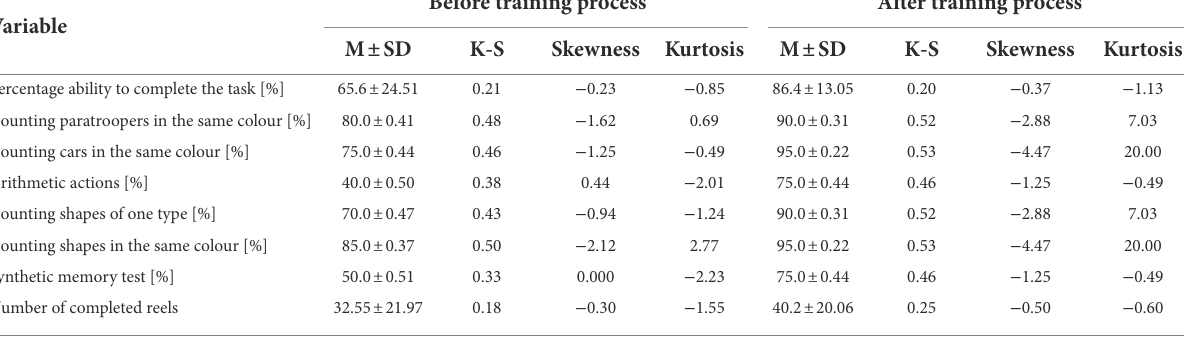
Before training process